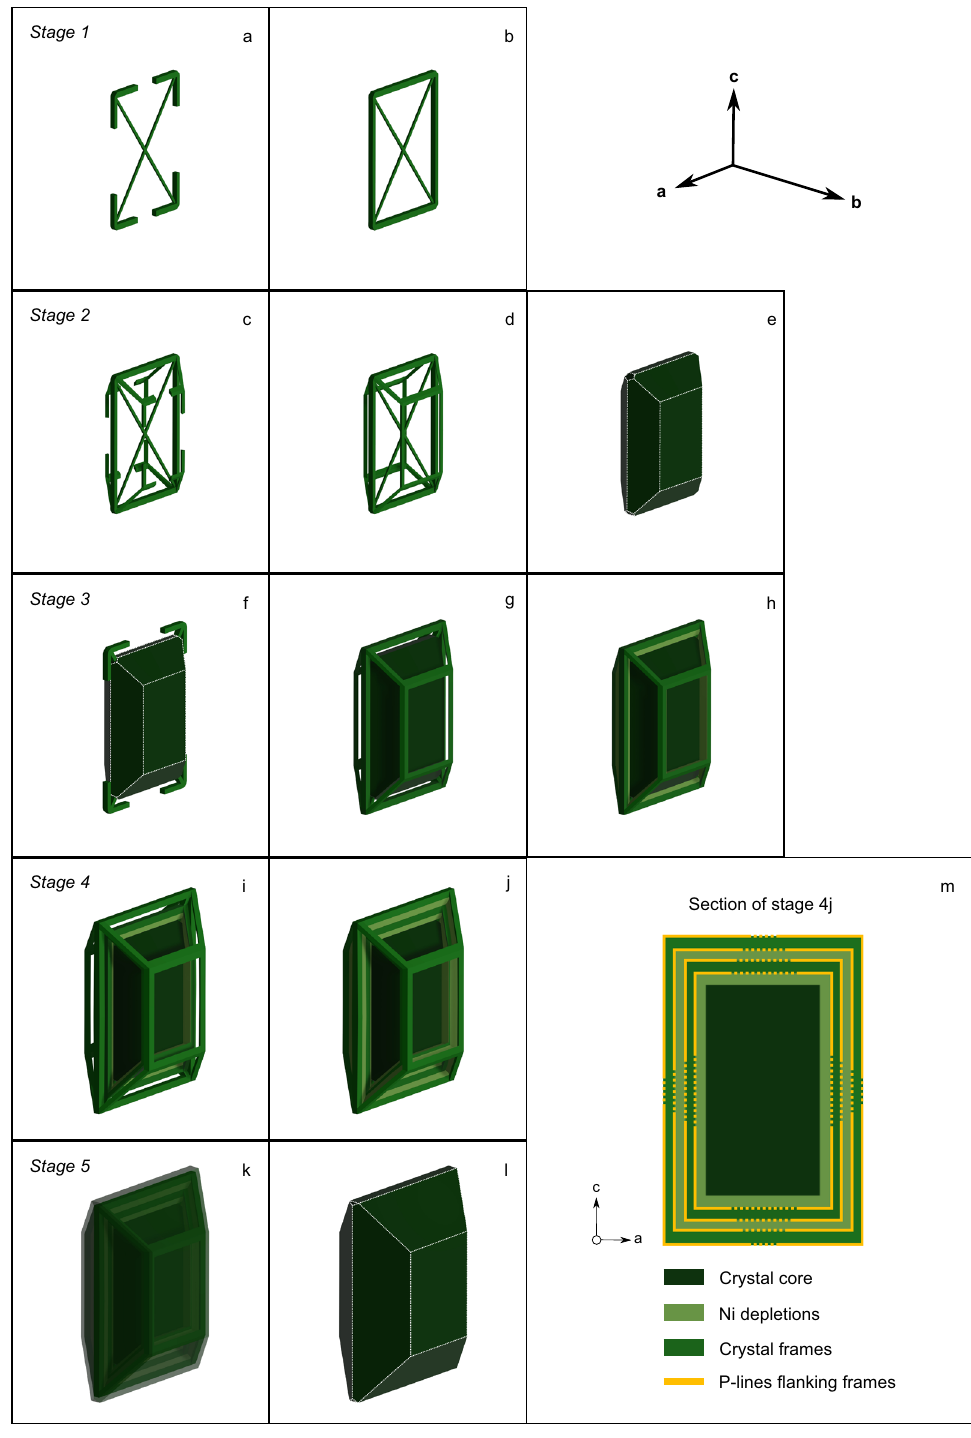
Fig. 4 Three-dimensional growth model for Los Hornitos olivine separated into fi ve stages. a , b Four dendrites simultaneously radiate from a central nucleus along the ac plane and enclose the external section. c – e Growth detaches along the b axis simultaneously from the four corners, conforming a crystal frame, where the olivine morphology is restricted to the edges of the crystal faces. Subsequently, the recently formed inner-frame is fi lled as maturation proceeds and a small olivine core is conformed. f – h Crystal growth continues at rapid rates and the initial dendrites grow again along the ac plane. A new crystal frame grows separated from the internal structure leaving behind a compositional boundary layer, which is responsible for the so- called Ni depletion structure in the studied olivines (pale green structure between two successive frames in ( h ). i , j The process repeats and a new frame and associated Ni depletion is externally developed in the emerging crystal. k , l Maturation proceeds from the most internal to the outer frame and the skeletal texture transit toward a polyhedral morphology. Zoning structures may be partially or fully erased depending of the timescales and storage conditions of the host magma. m Crystal section along plane ac showing the distribution of P-enriched lines with respect to the location of crystal frames. Segmented versus continuous lines indicate the higher P-intensities often observed near the crystal